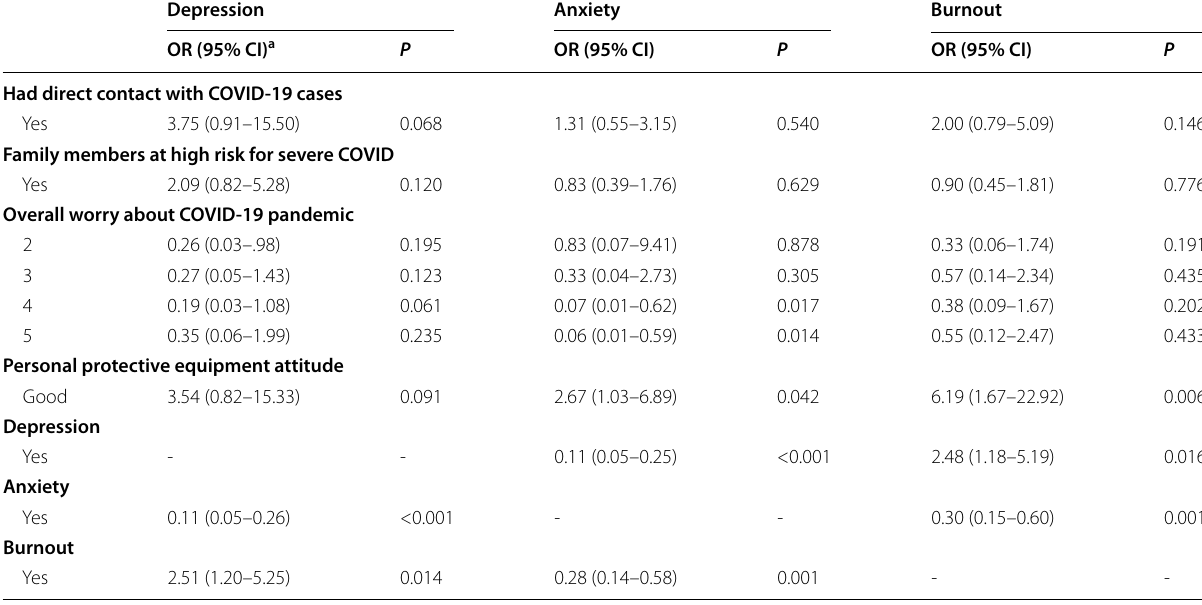
Table 5 Multivariate regression analysis for depression, anxiety, and burnout predictors among Egyptian house officers amid the COVID-19